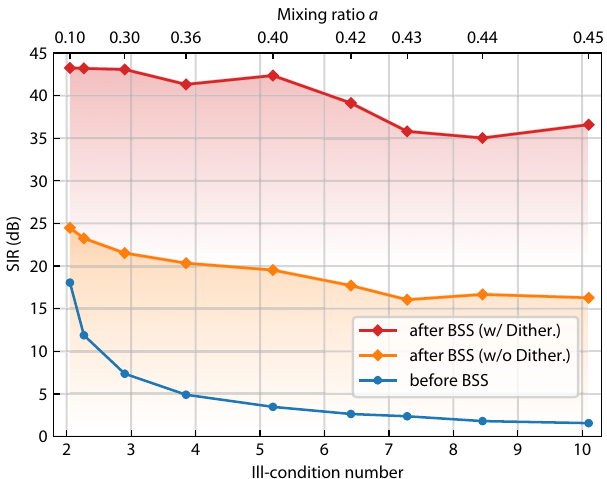
Fig. 5 | BSS performance on ill-conditioned mixtures. Blue, red, and orange curves are the SIR before the BSS, after BSS with dithering control, and after BSS without dithering control, respectively. The mixing matrix H is de fi ned by the mixingratio a by H = ½½ a ,1 (cid:3) a (cid:2) , ½ 1 (cid:3) a , a (cid:2)(cid:2) .Thecorrespondingill-conditionnumberis calculated by Eq.